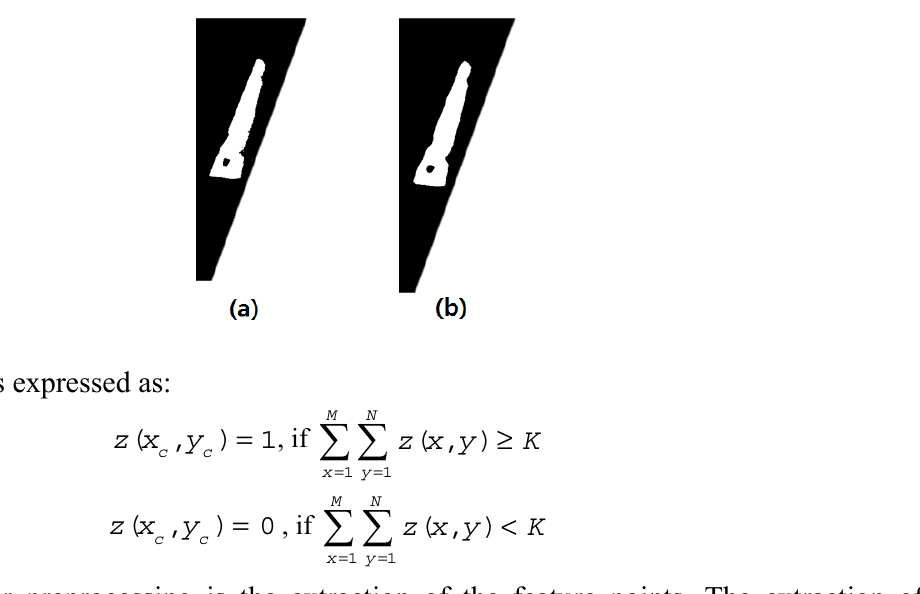
Figure 5. Median filter. ( a ) Threshold image; ( b ) Image after Median